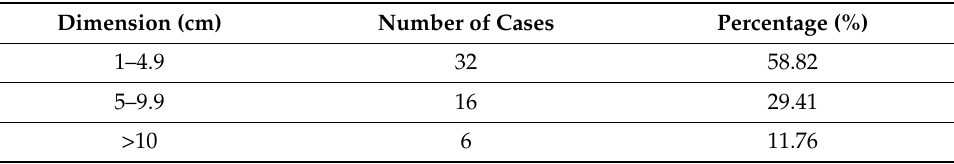
Table 2. The dimensions of the identified vegetations in association with incidence, both in number and percentage, in our studied cases.